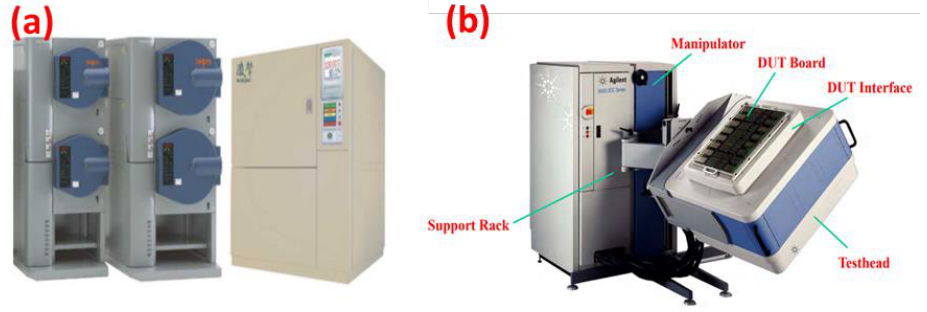
Figure 1. The uHAST ( a ) and testing equipment (Agilent 9300 SOC series, ( b )). Reprinted/adapted with permission from Ref. [23]. 2022, Integrated Service Technology Inc.